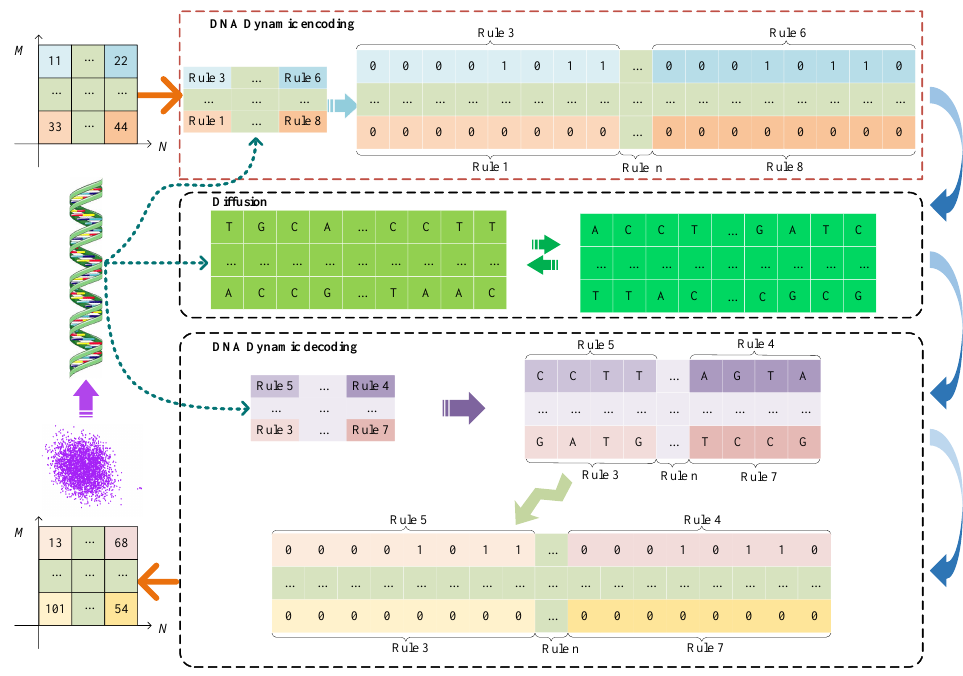
Figure 3. The mechanism process of M × N image